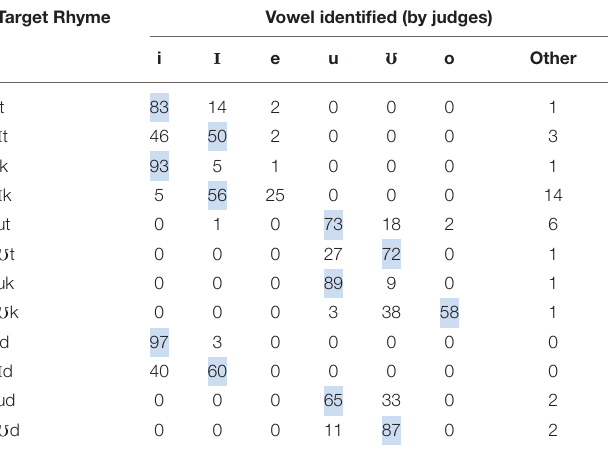
TABLE 9 | Confusions (%) by target rhyme. Target